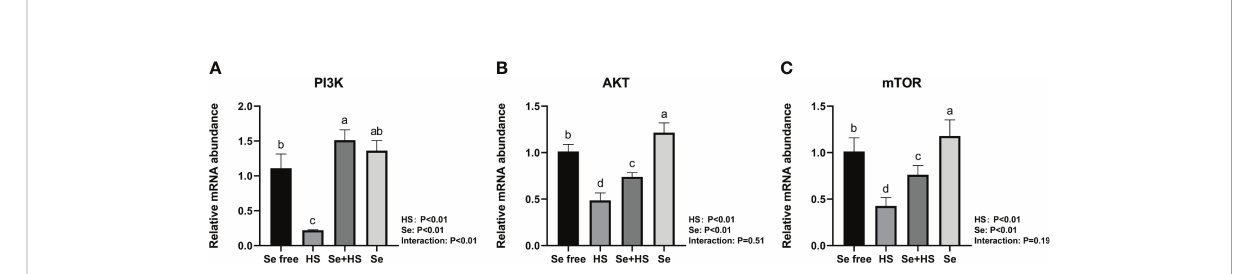
FIGURE 12 Effects of HMSeBA on the mRNA expression of PI3K/AKT/mTOR in the mammary gland of mice under HS (n = 12). The relative mRNA expression levels of PI3K (A) , AKT (B) , and, mTOR (C) were measured using real-time quantitative PCR. a-d Different lowercase letters indicate extremely signi fi cant differences between two groups ( P < 0.01), while the same lowercase letters indicate no signi fi cant difference between two groups ( P > 0.05).